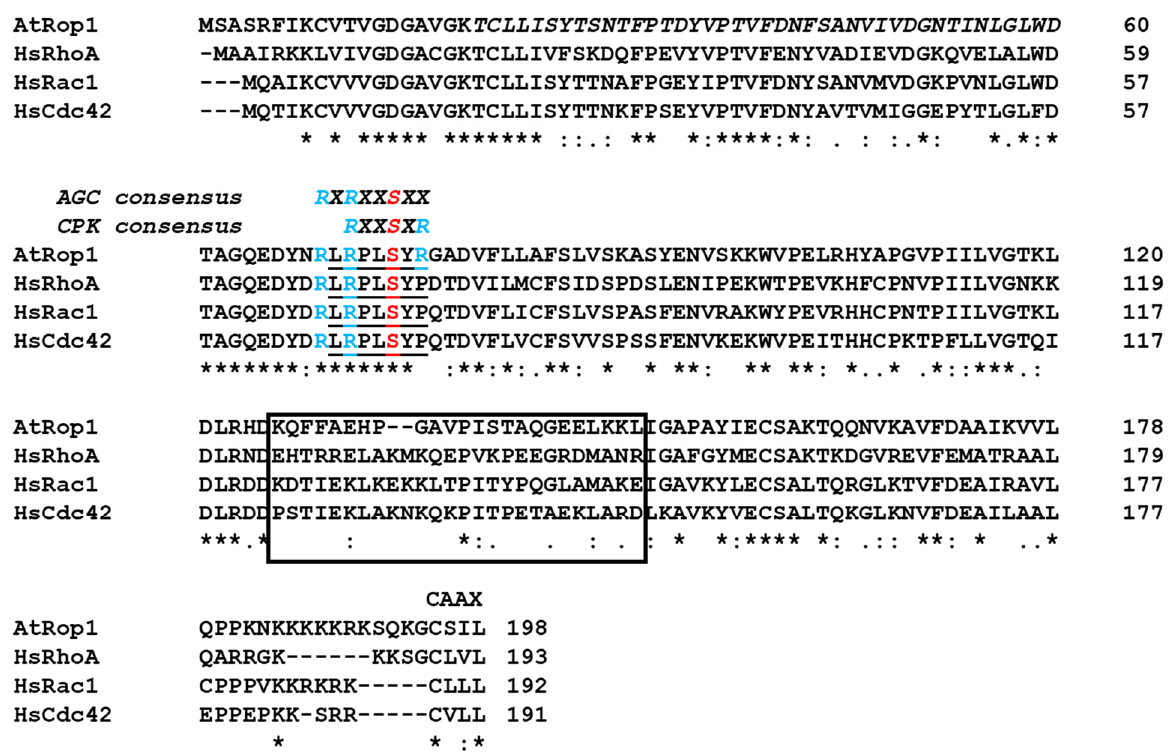
Figure 1. Sequence comparison of the ROP1 GTPase of Arabidopsis thalina (AtROP1) with the Homo sapiens Rho-type GTPases HsRhoA, HsRac1, and HsCdc42. The evolutionarily conserved AGC kinase phosphorylation site overlapping with the phosphorylation consensus site of plant-specific calcium-dependent protein kinases (CPKs) is indicated above the underlined corresponding sequence of the G-proteins. Conserved Arg residues surrounding the phosphorylation site S74 of AtROP1 are highlighted in blue. The less-conserved Rho-insert region is boxed. The conserved C-terminal CAAX motif is also indicated. * indicates evolutionary conserved residues.